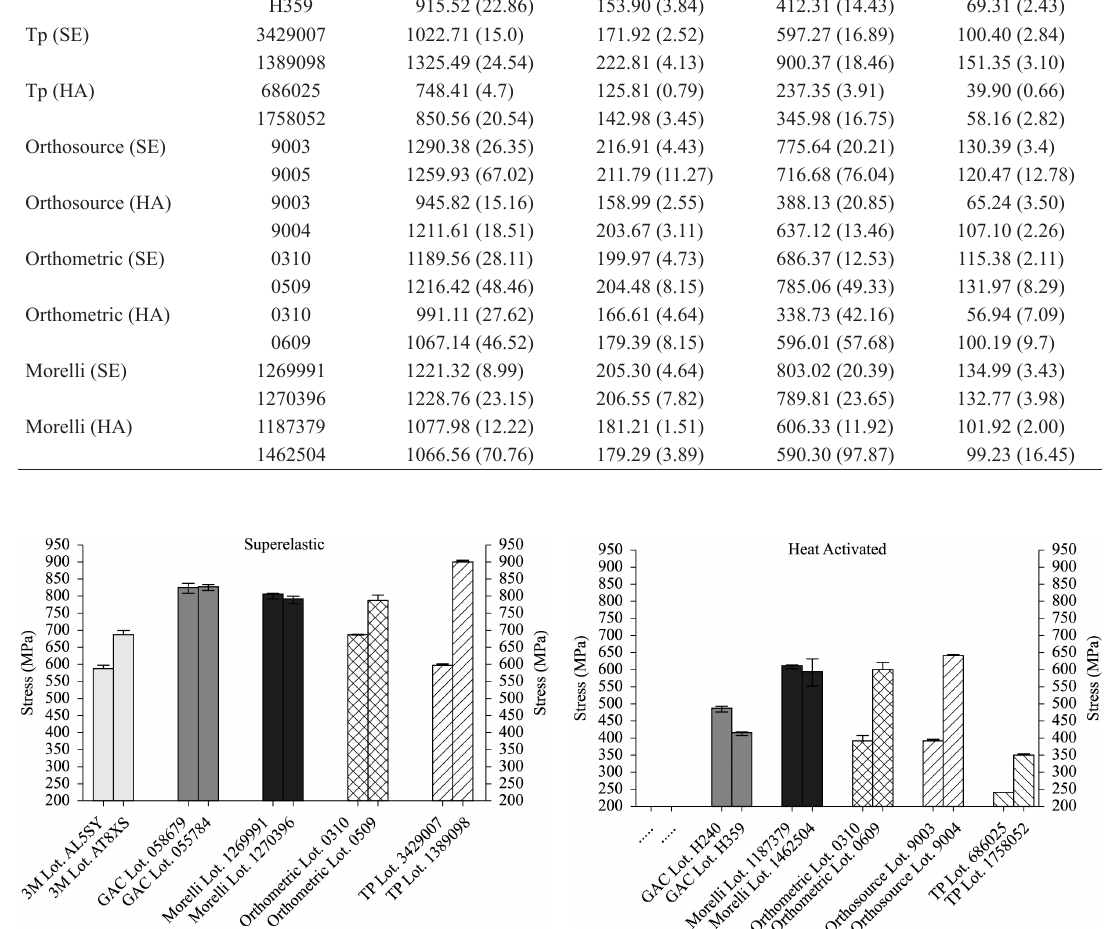
SE showed the lowest difference between lots (0.25%) and the best homogeneity